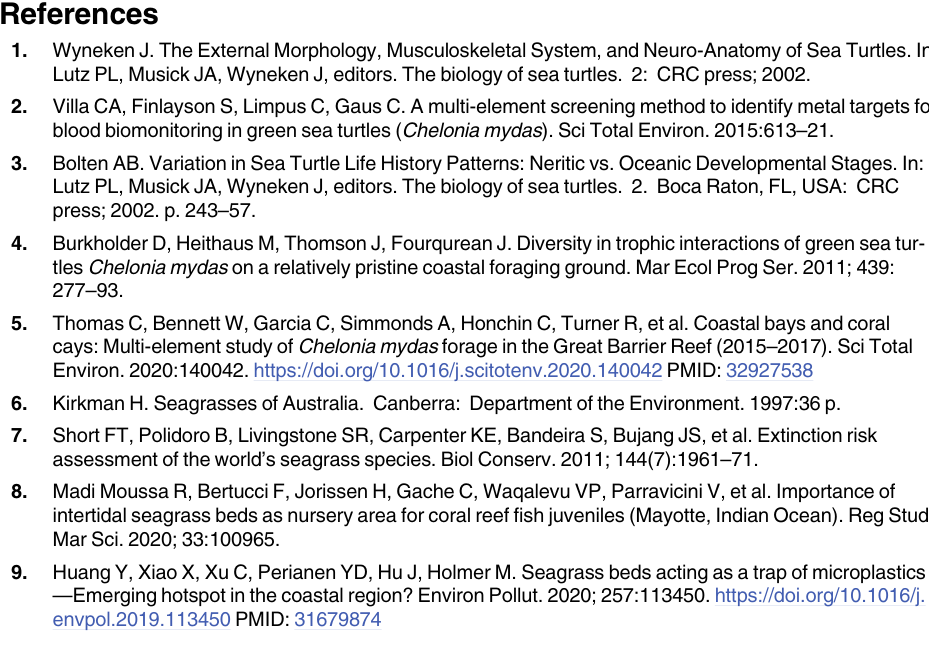
S1 Fig. RAW data analysed and reported in research article “Trace element concentrations in forage seagrass species of Chelonia mydas along the Great Barrier